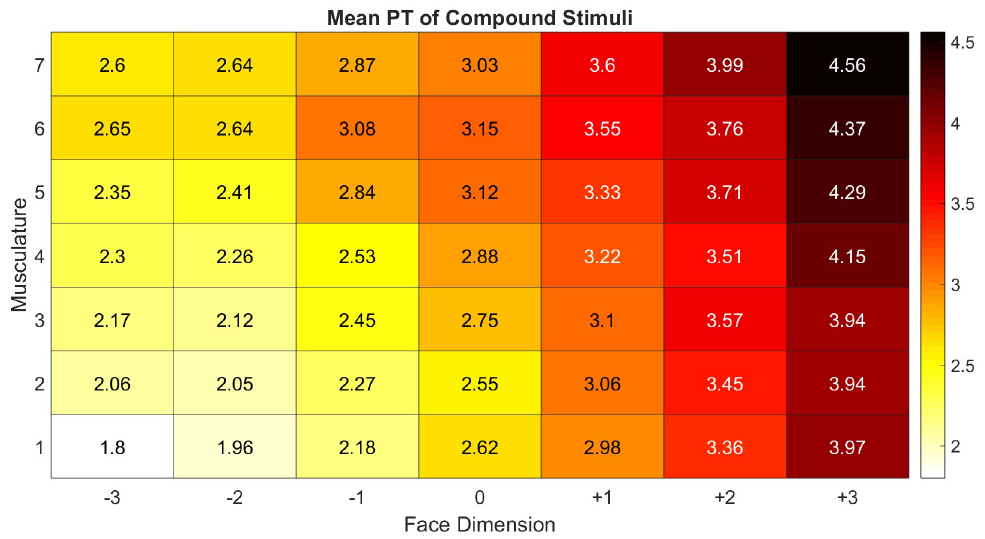
Fig 3. Heatmap of mean perceived threat (PT) (on a scale of 1–7) for the compound stimuli. Compounds increase in facial dimension along the X axis. Compounds increase in musculature along the Y axis.